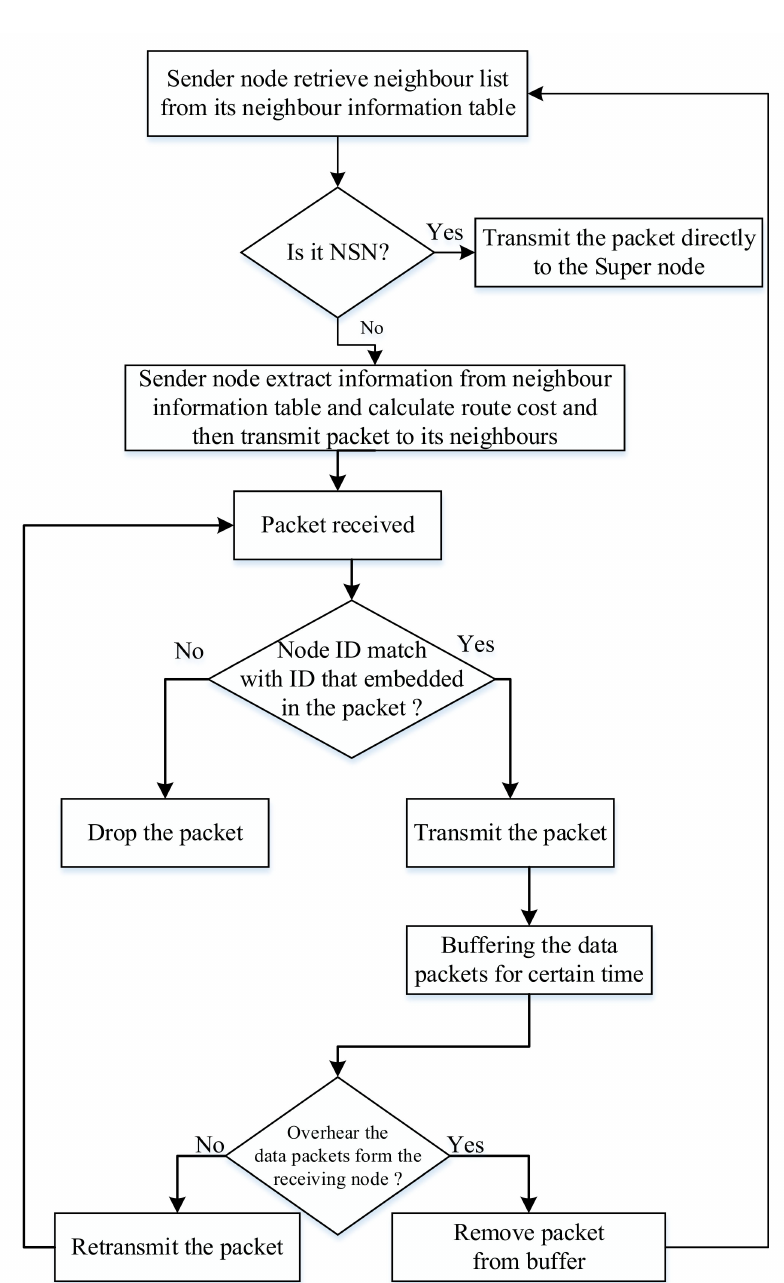
Figure 6. Flowchart of the underwater data forwarding phase in the proposed